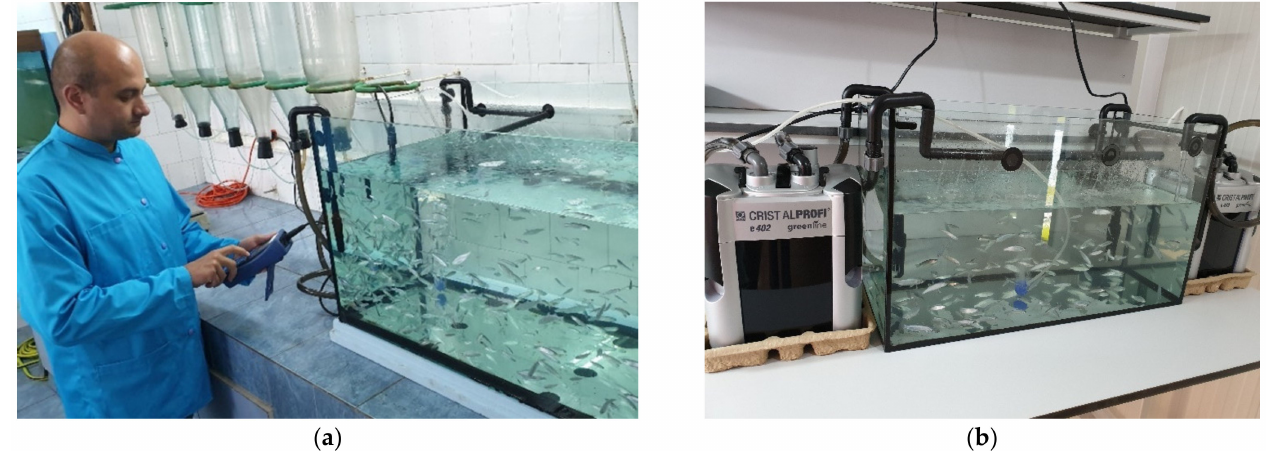
Figure 2. ( a ) Fish batch extracted from the FRP tank and transferred to the 50-L aquarium; ( b ) Experi- mental lot in the temperature-controlled room prior to test initiation (original